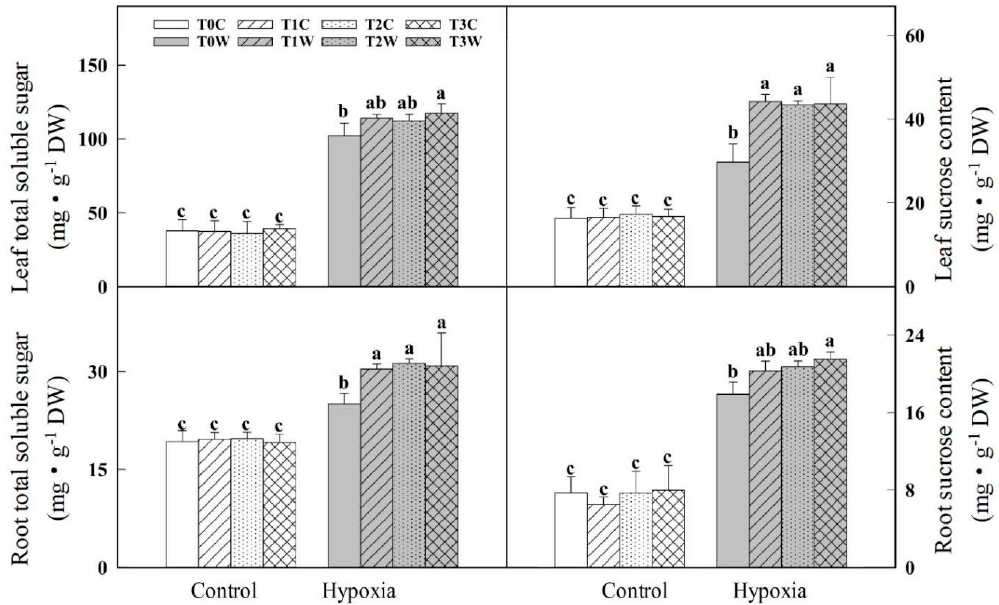
Figure 3. Effects of waterlogging priming on total soluble sugar and sucrose content of offspring plants under hypoxia stress in wheat seedling. Note: T0C, no priming + no offspring hypoxia stress; T0W, no priming + offspring hypoxia stress; T1C, one-generation priming + no offspring hypoxia stress; T1W, one-generation priming + offspring hypoxia stress; T2C, two-generation priming + no offspring hypoxia stress; T2W, two-generation priming + offspring hypoxia stress; T3C, three-gen- eration priming + no offspring hypoxia stress; T3W, three-generation priming + offspring hypoxia stress. Data are means ± SE (n = 3). Different lowercase letters indicate the significant difference at p < 0.05 level.